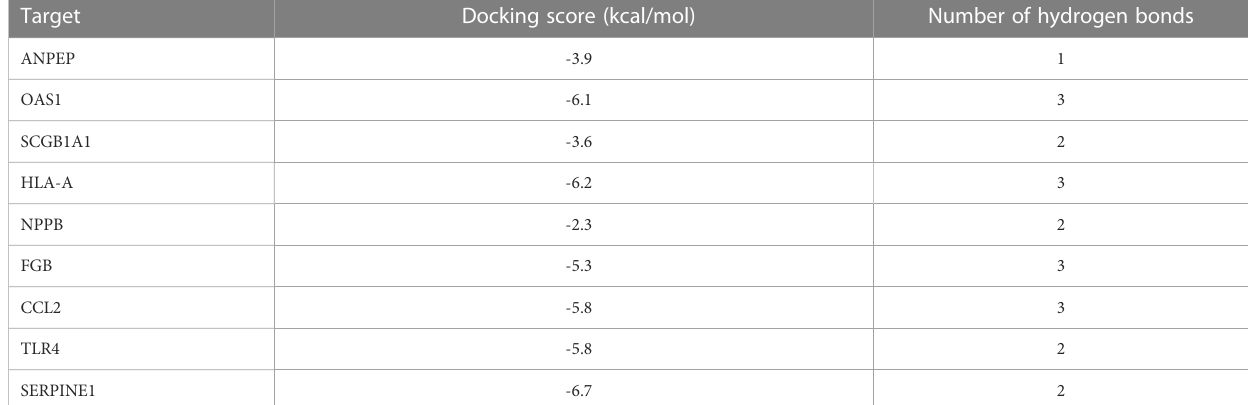
TABLE 4 The docking energies and number of hydrogen bonds of 9 targets and quercetin.